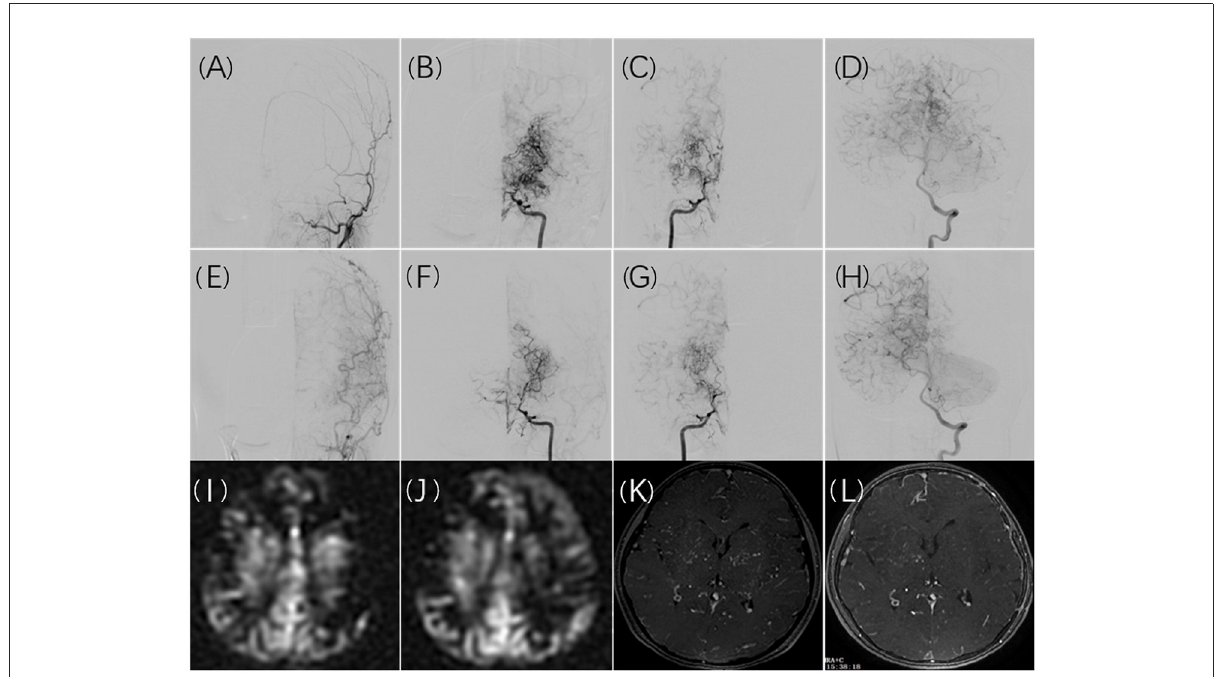
FIGURE2 A 10-year-old girl presented with recurrent numbness of the right limbs. Cerebral angiography revealed bilateral moyamoya disease (B,C) without collateral anastomosis for the left ECA (A) . Collateral compensation from the posterior circulation was noted (D) . Six months after surgical revascularization, the left ECA angiogram demonstrated graft patency and good angiogenesis (E) . Shrinkage of moyamoya vessels on both hemispheres was noted (F,G) , and the left internal carotid artery compensated for the right hemisphere (F) . The compensatory range of the posterior circulation shifted to the non-operated territory (H) . The MRI ASL images showed hypoperfusion in the cerebral cortex (I) . The hypoperfusion in the left cortex improved after surgical revascularization with a decrease in perfusion in the left basal ganglia (J) . Ivy collateral vessels in contrast MRA decreased obviously in the left and right basal ganglia after surgical revascularization (K,L)